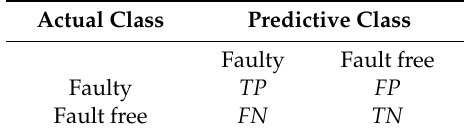
Table 5. Confusion matrix of binary classification